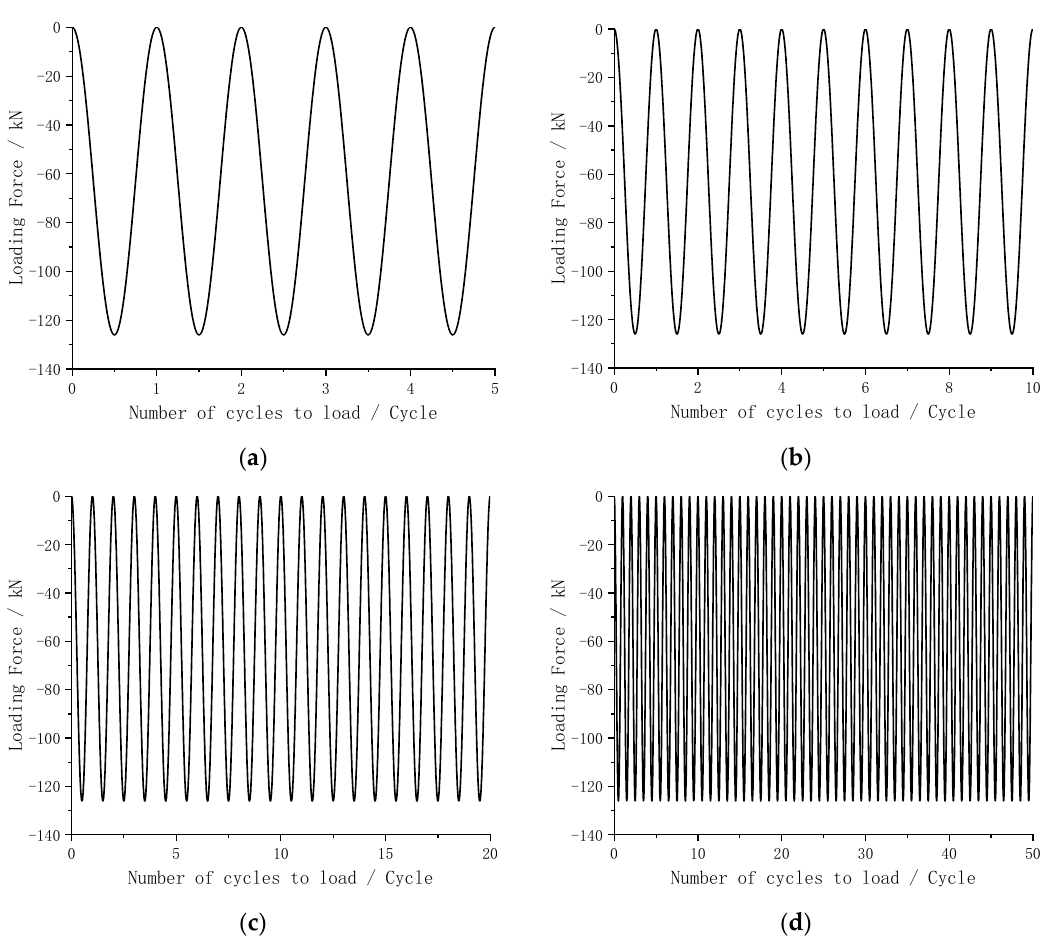
Figure 7. Loading curve of rail-sleeper discrete element model. ( a ) 5 Hz. ( b ) 10 Hz. ( c ) 20 Hz. ( d ) 50 Hz. Different loading frequencies correspond to different train speeds. The relationship between train speed and action frequency is shown in Formula (2)